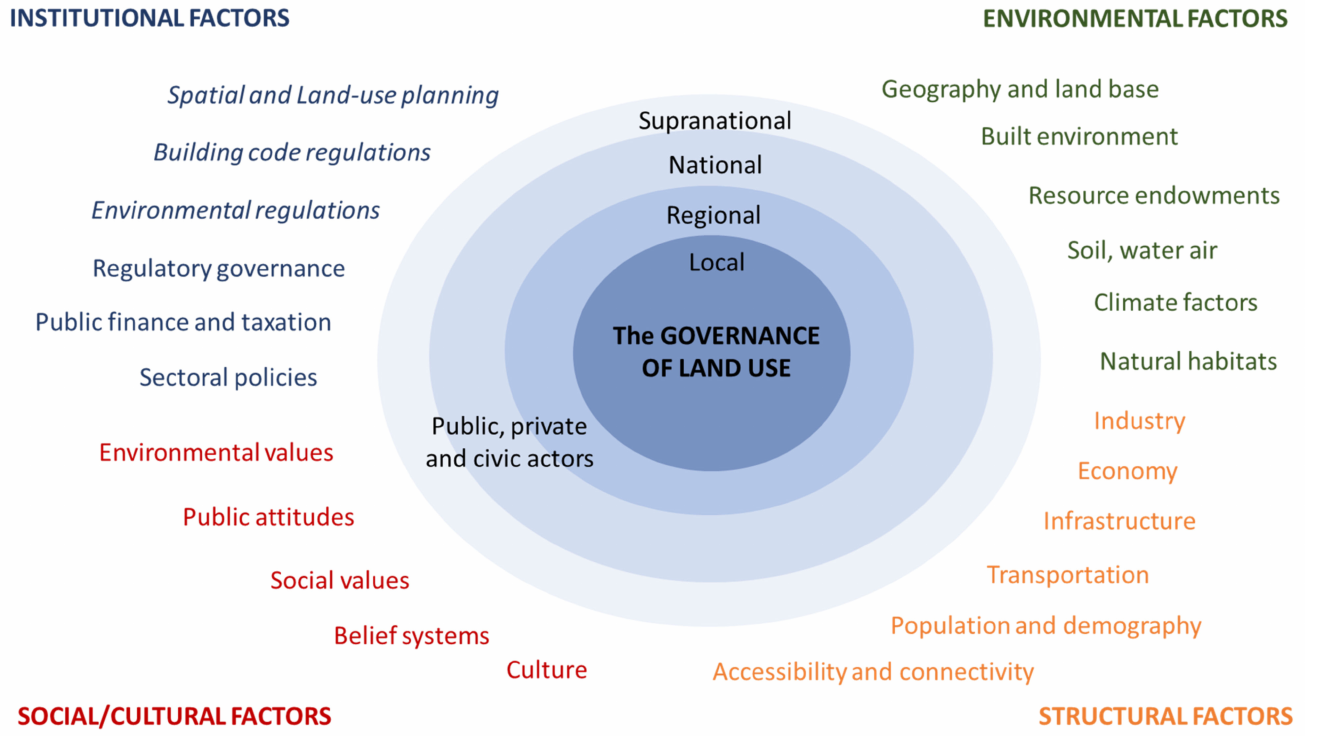
Figure 1. The governance of land use: conceptual